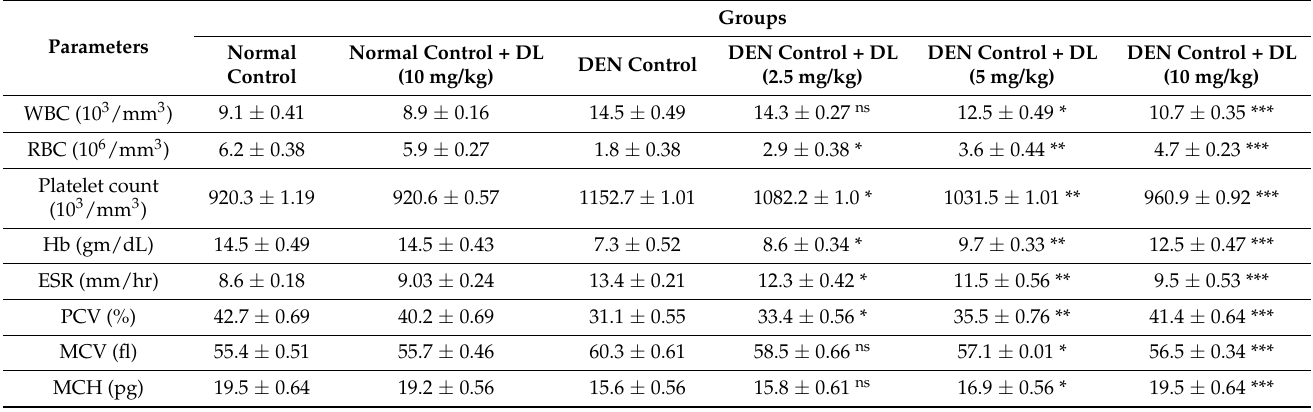
Table 4. Effect of DL on hematological